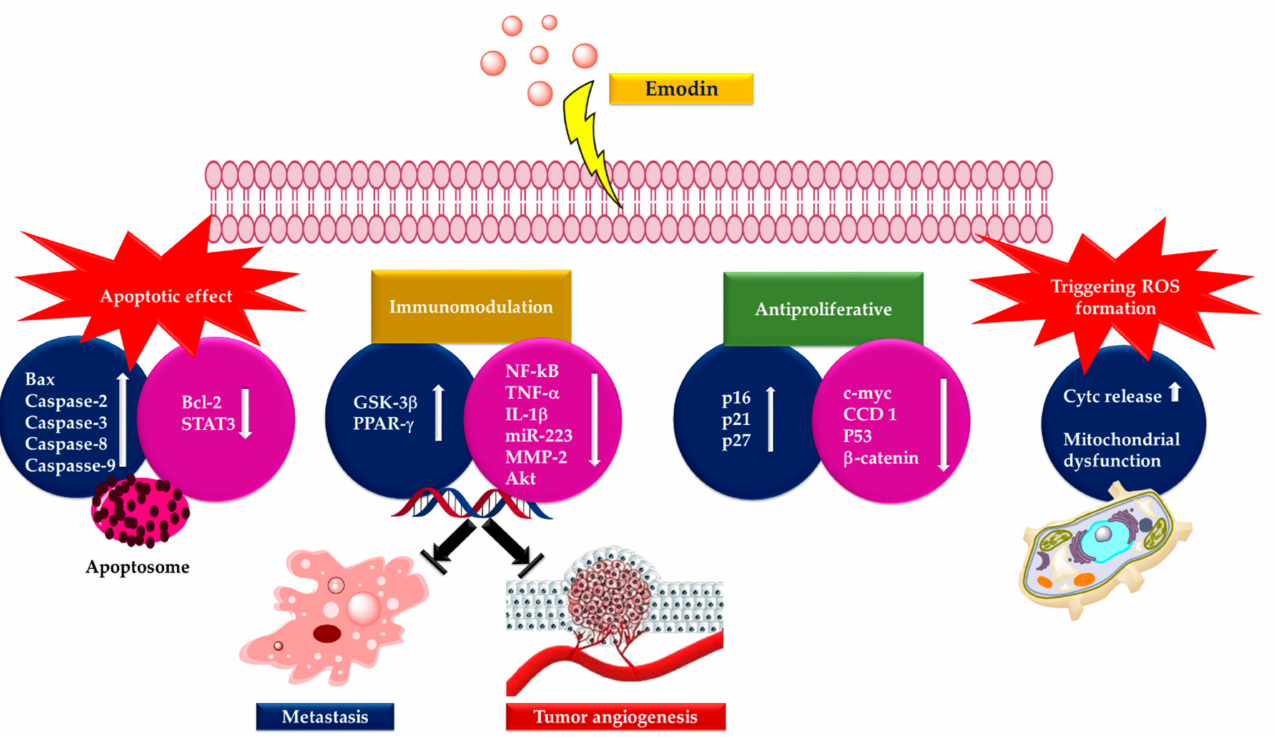
Figure 6. Antitumoral mechanisms of